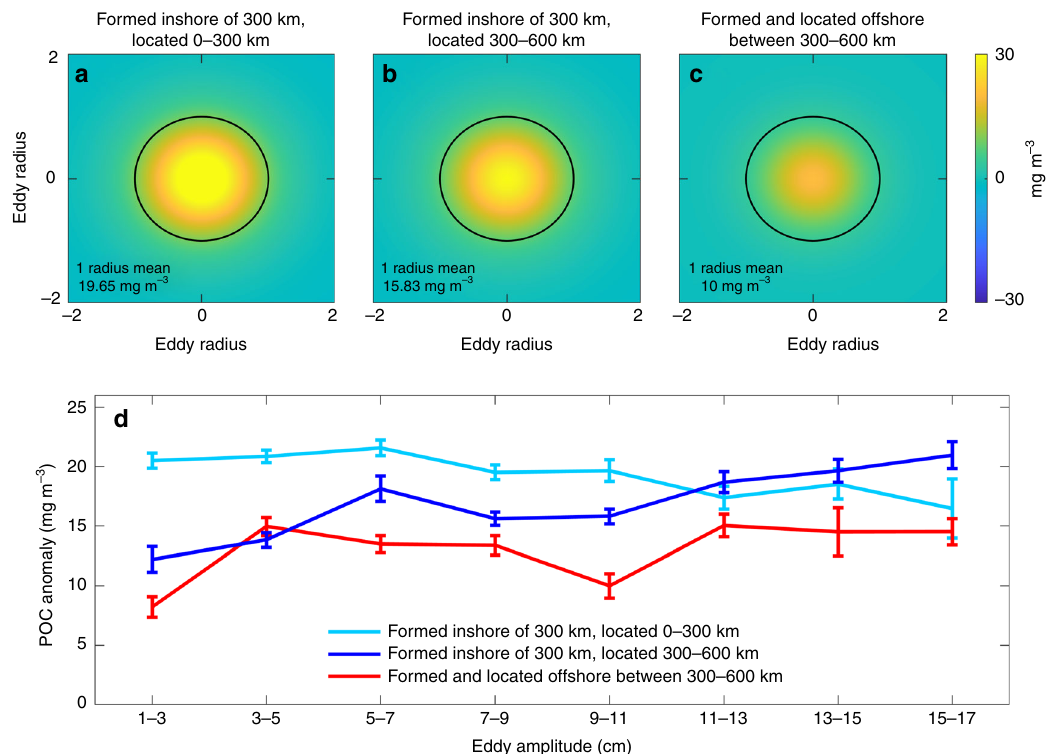
Fig. 3 Particulate organic carbon composites and anomalies. Cyclonic eddies identi fi ed from satellite altimetry were collocated with particulate organic carbon (POC) anomalies that were derived from satellite observations. To isolate the POC signature associated with each eddy, the POC anomaly was extracted within 2-by-2 eddy radii from the eddy center, and the distance from the eddy center was normalized by the eddy radius (unitless). A 2D Gaussian function was fi tted to each POC anomaly fi eld, and composites were computed by averaging the POC anomalies for eddies of similar amplitude (see Supplementary Fig. 2). a – c Composites of POC anomalies within 2-by-2 eddy radii for cyclonic eddies with amplitudes 9 – 11 cm. The black circle represents the boundary for one eddy radius. d Mean POC anomaly (mg m − 3 ) and standard error within one eddy radius grouped by eddy amplitude